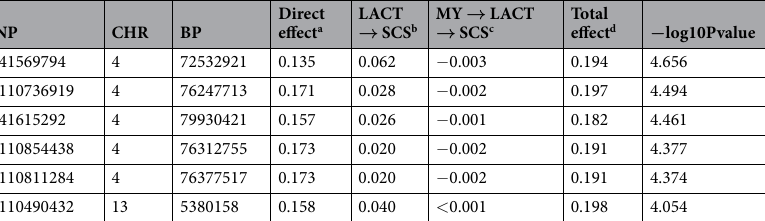
Table 3. Effect decomposition provided by SEM-GWAS for the significant SNP identified by MTM-GWAS. CHR: chromosome; BP: SNP location in bp; LACT: lactose; SCS: somatic cell score; MY: milk yield. a Direct effect of SNP on SCS. b Indirect effect on SCS mediated by LACT. c Indirect effect on SCS mediated by MY and LACT. d Sum of direct and indirect SNP effect.